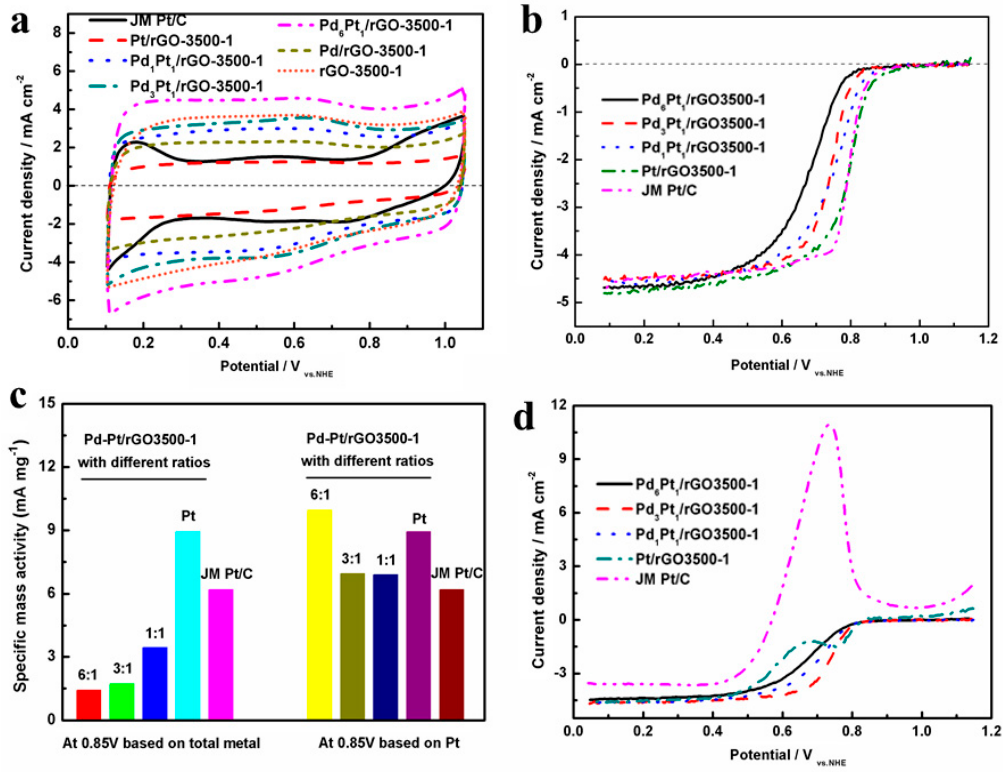
Figure 6. ( a ) C–V curves and ( b ) current-potential (I–V) polarization curves of the Pd 6 Pt 1 /rGO3500-1, Pd 3 Pt 1 /rGO3500-1, Pd 1 Pt 1 /rGO3500-1, Pt/rGO3500-1, and JM Pt/C electrocatalysts in the 0.5 M H 2 SO 4 solution, scan rate for C–V curves and I–V curves: 50 mV s − 1 and 5 mV s − 1 , respectively. ( c ) Specific mass activities of different electrocatalysts based on total metal (Pd+Pt, bars at left) and Pt metal (bars at right). The mass loading on the GC electrode for total electrocatalysts and for Pd+Pt metal are 310 and 62 μ g cm − 2 , respectively. ( d ) I–V curves of the different electrocatalysts in the 0.5 M H 2 SO 4 solution with 0.5 M methanol with the potential scan rate of 5 mV s − 1 .